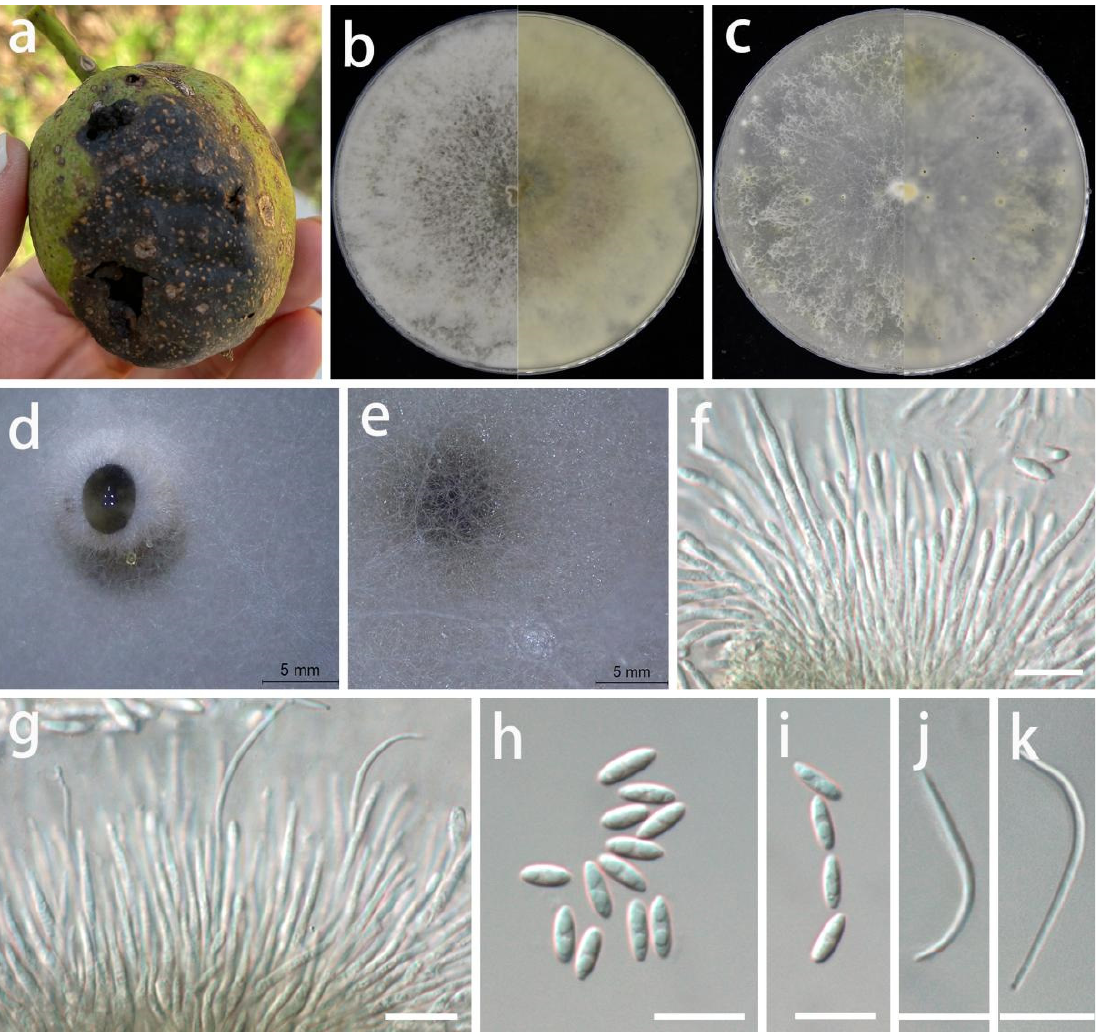
Figure 7. Diaporthe juglandigena (GUCC 422.16). ( a ) Host: Juglans regia . ( b ) Colony on PDA after 2 wk (left: above, right: reverse). ( c ) Colony on OA after 2 wk (left: above, right: reverse). ( d , e ) Mass of conidia. ( f , g ) Conidiogenous cells. ( h , i ) Alpha conidia. ( j , k ) Beta conidia. Scale bars: ( f – k ) = 10 μ m.